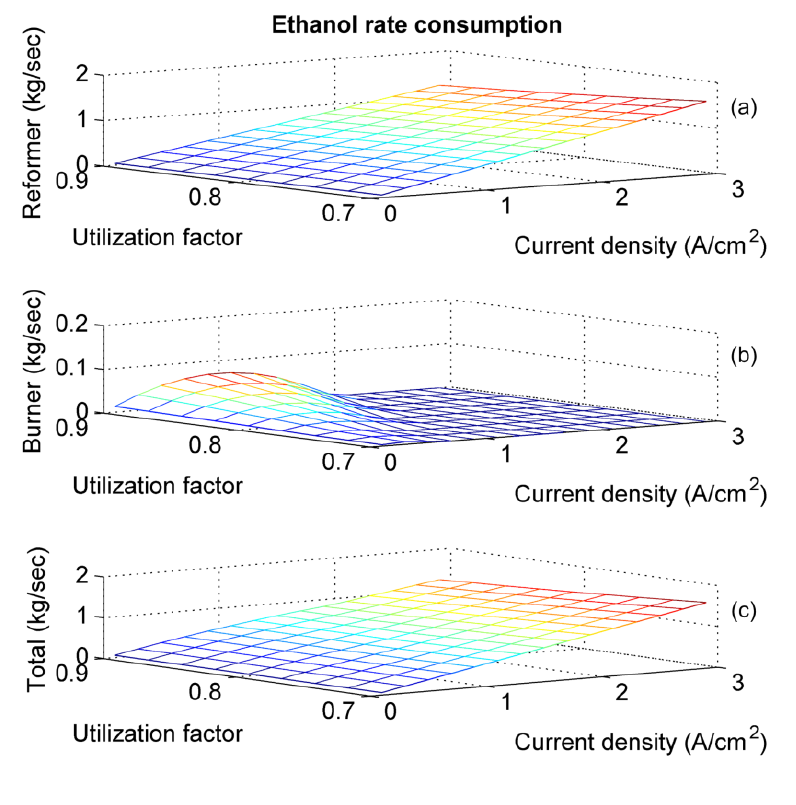
Figure 12. The effect of current density and fuel utilization factor on the ethanol consumption rate in: ( a ) the reformer, ( b ) the burner, ( c ) the whole SOFC-GT system; =600 °C and r = T FC p